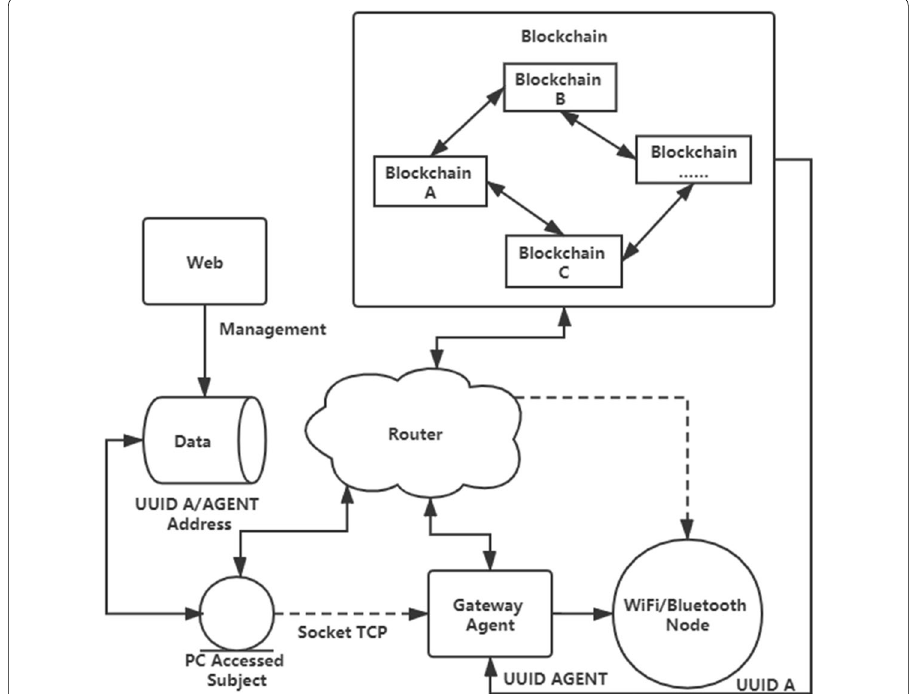
Fig. 2 Network topology structure. The addresses of UUIDA and UUIDAgents accessing the device and gateway agents are stored in the local PC database, managed by the Web module configuration. After the gateway device is started, the Web module begins to listen on the port. When PC performs a read UUIDA operation, it needs to search the IP address of the reading device from the database and establish a socket connection to this address. After receiving the packet, the gateway agent sends the data to the router, which forwards the data to the corresponding node based on the contents of the routing table to invoke the smart contract on the blockchain. The blockchain node starts with an RPC address that is connected to the gateway through web3J’s interface to perform the same operations as the